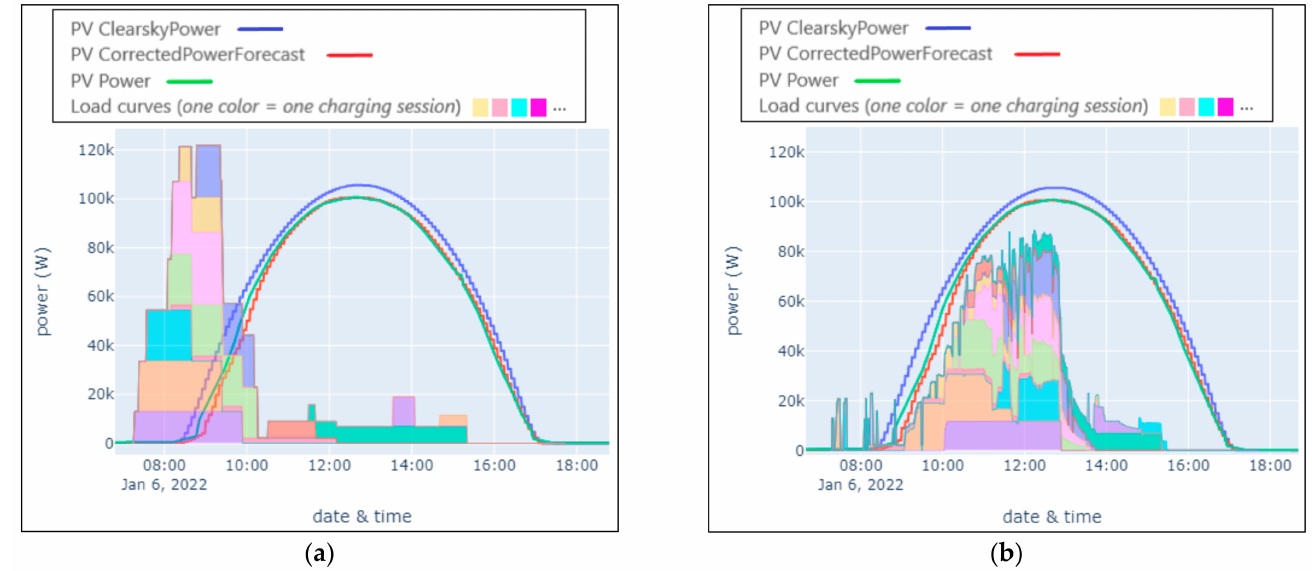
Figure 5. Results of 6th January 2022: ( a ) Stacked energies without control. The self-production rate SP u is equal to 31%; ( b ) stacked energies with control. The self-production rate SP is equal to